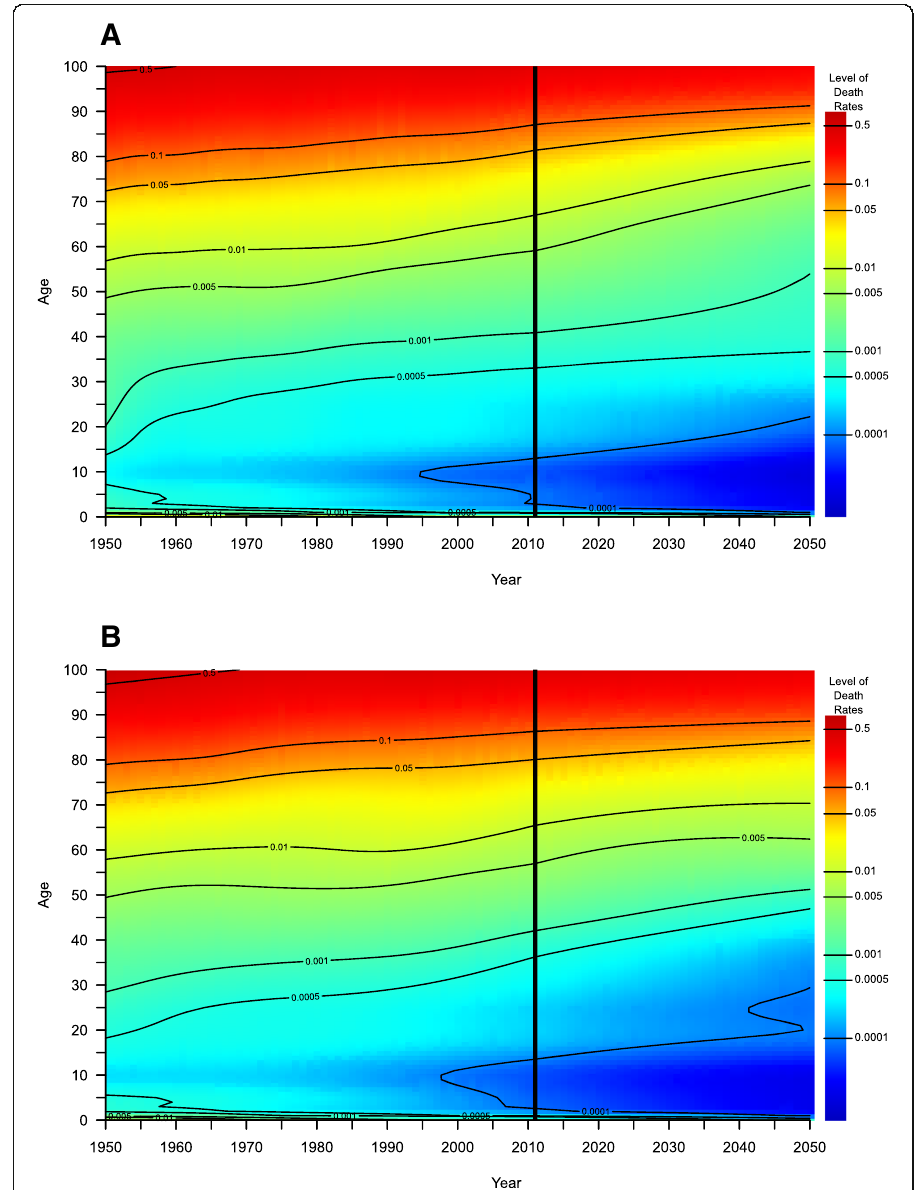
Fig. 14 Death rates by single age; observed in the calendar years 1950 to 2011 and forecasted with our linear core model in the years 2012 to 2050 for women in the UK ( top ) and Denmark ( bottom ). The transition from observed to forecasted death rates is illustrated by the vertical black line in both